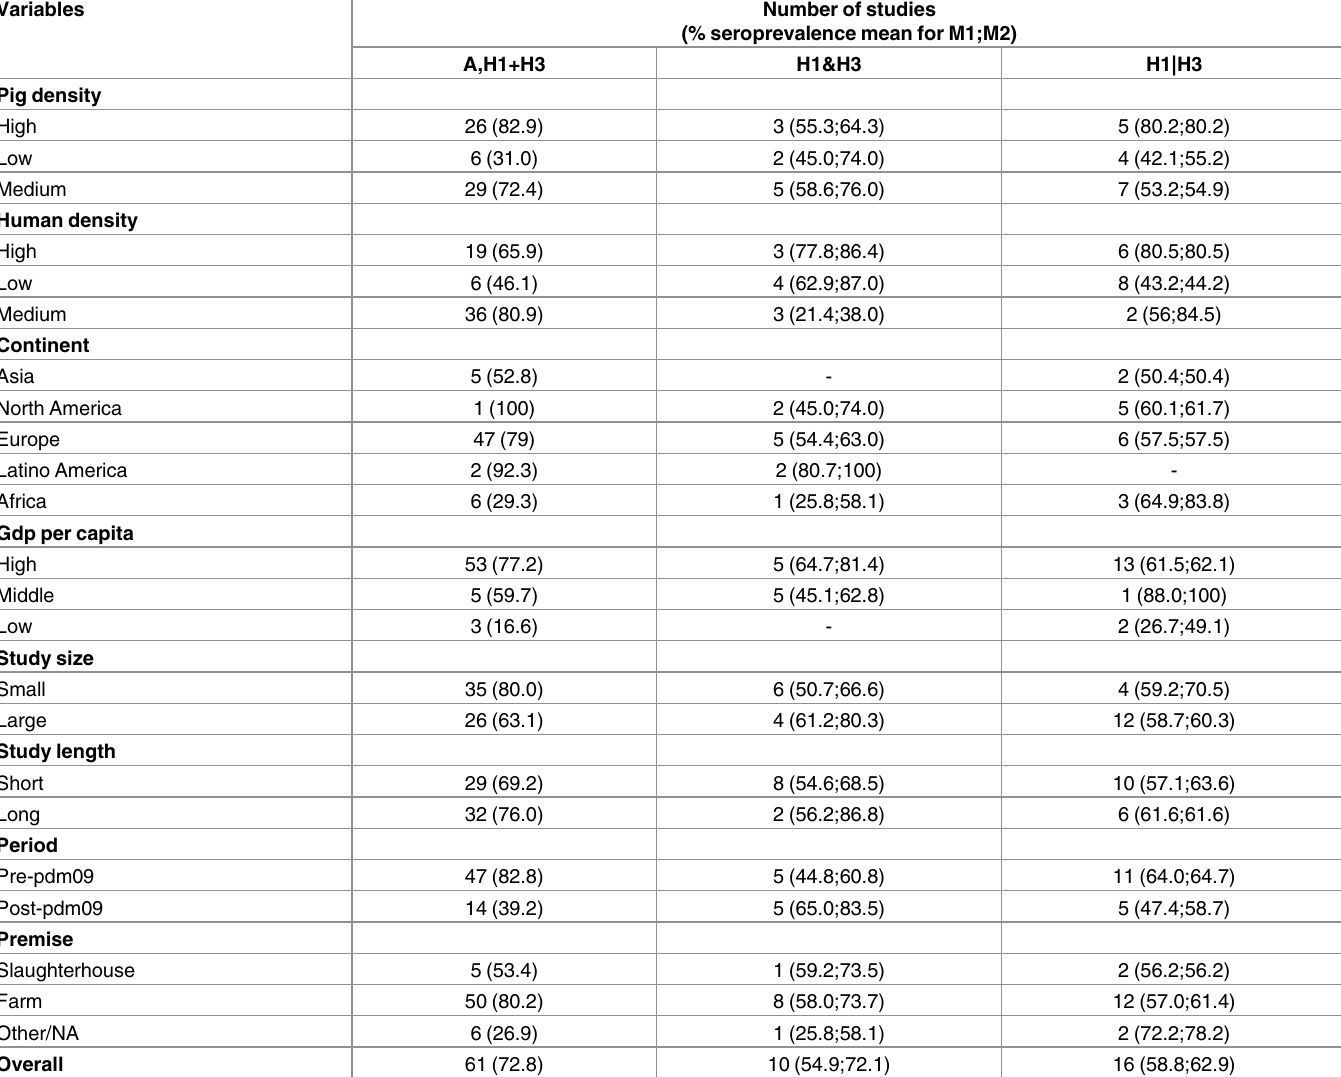
Table 3. Number of the studies and herd seroprevalence means for the different